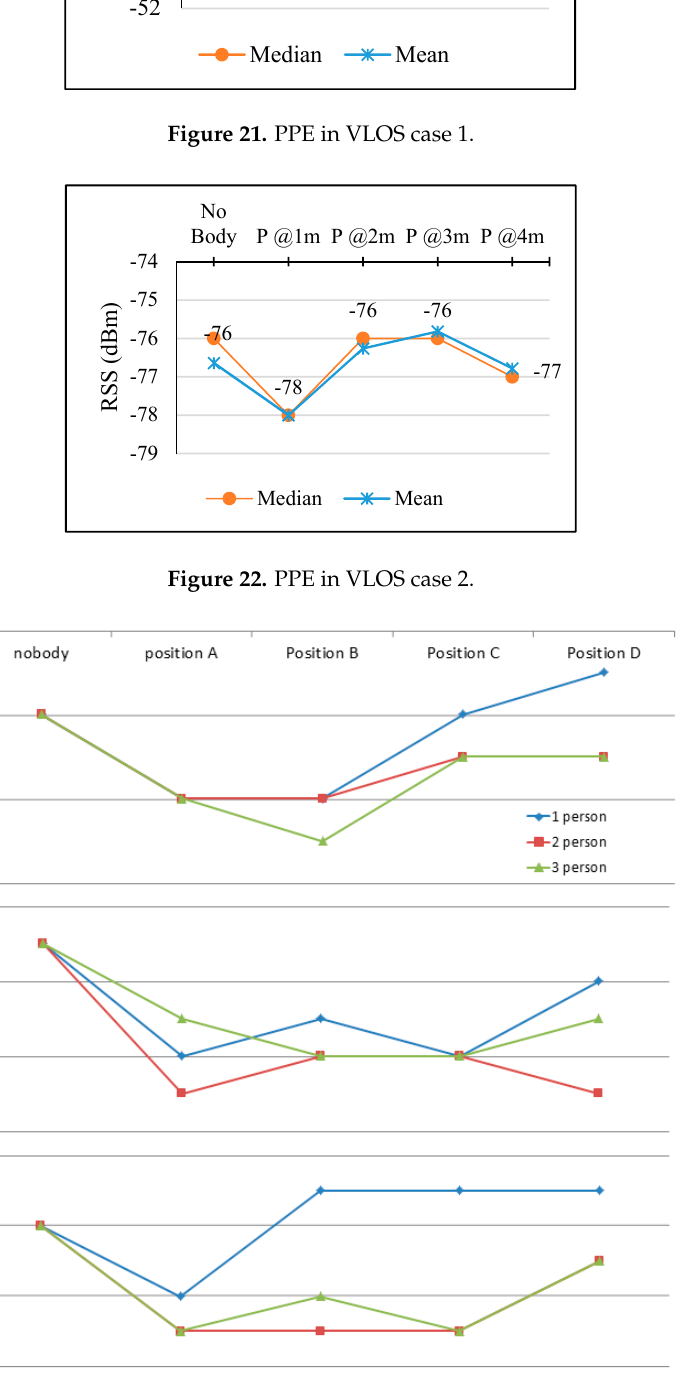
Figure 23. People presence effect on RSS and influence distance. Table 4. People position in experiments to define PPE influence distance.